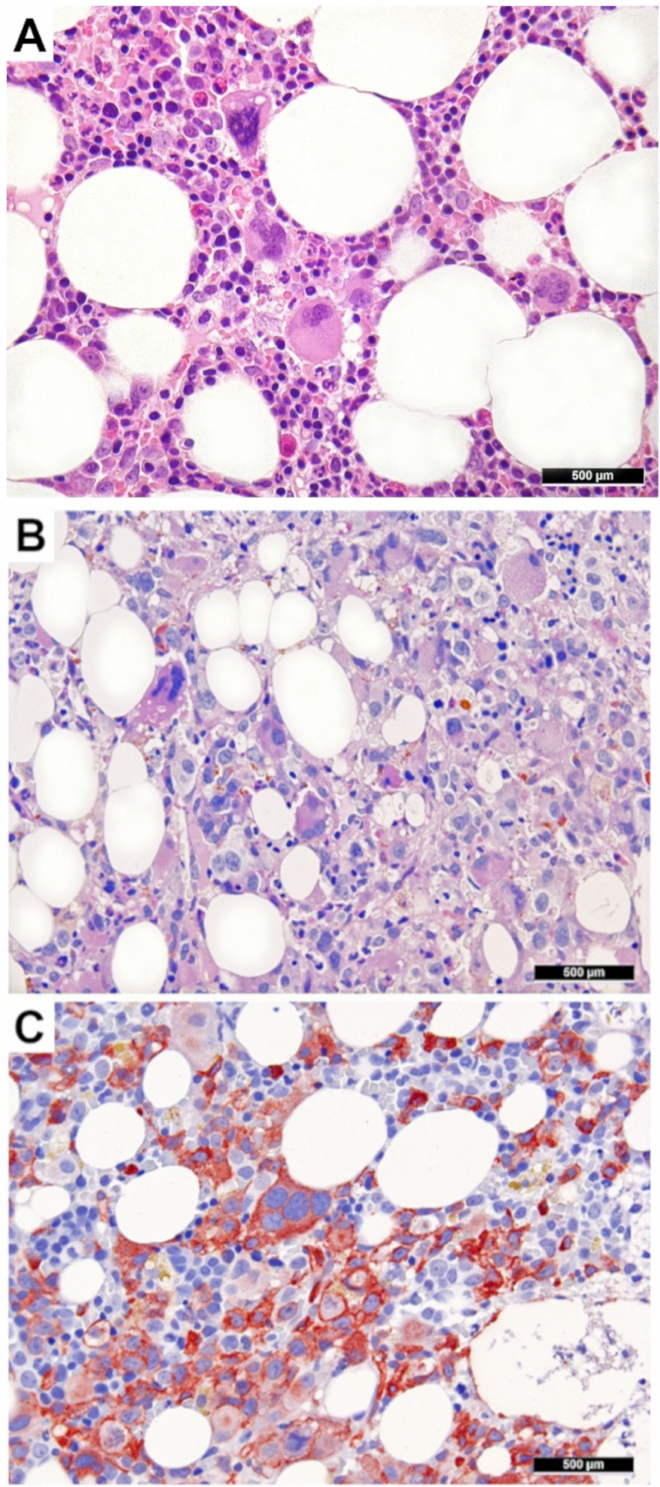
Figure 1. Sequential bone marrow of a myeloproliferative neoplasm) patient suffering from essential thrombocythemia ( A ), who progressed to secondary acute myeloid leukemia ( B ) with increased CD34+ blasts ( C ) and clearly perceptible myelodysplastic features (micromegakaryocytes, megakary- ocytes with alobated nuclei and such with nuclear separations, CD34+